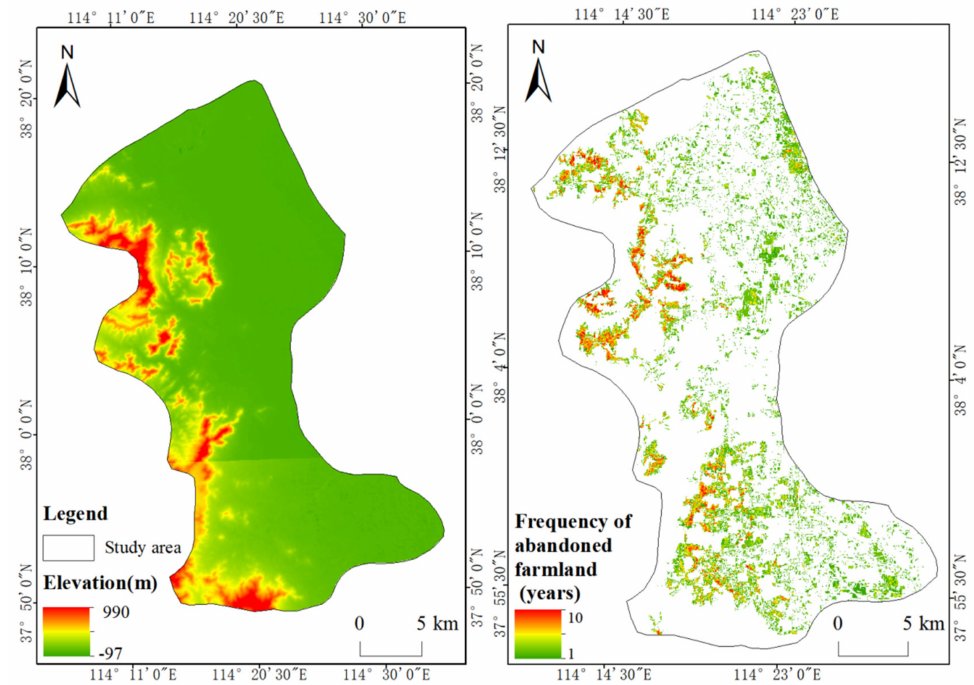
Figure 10. Distribution of the farmland abandonment frequency in Luquan for the period of 2011–2020.